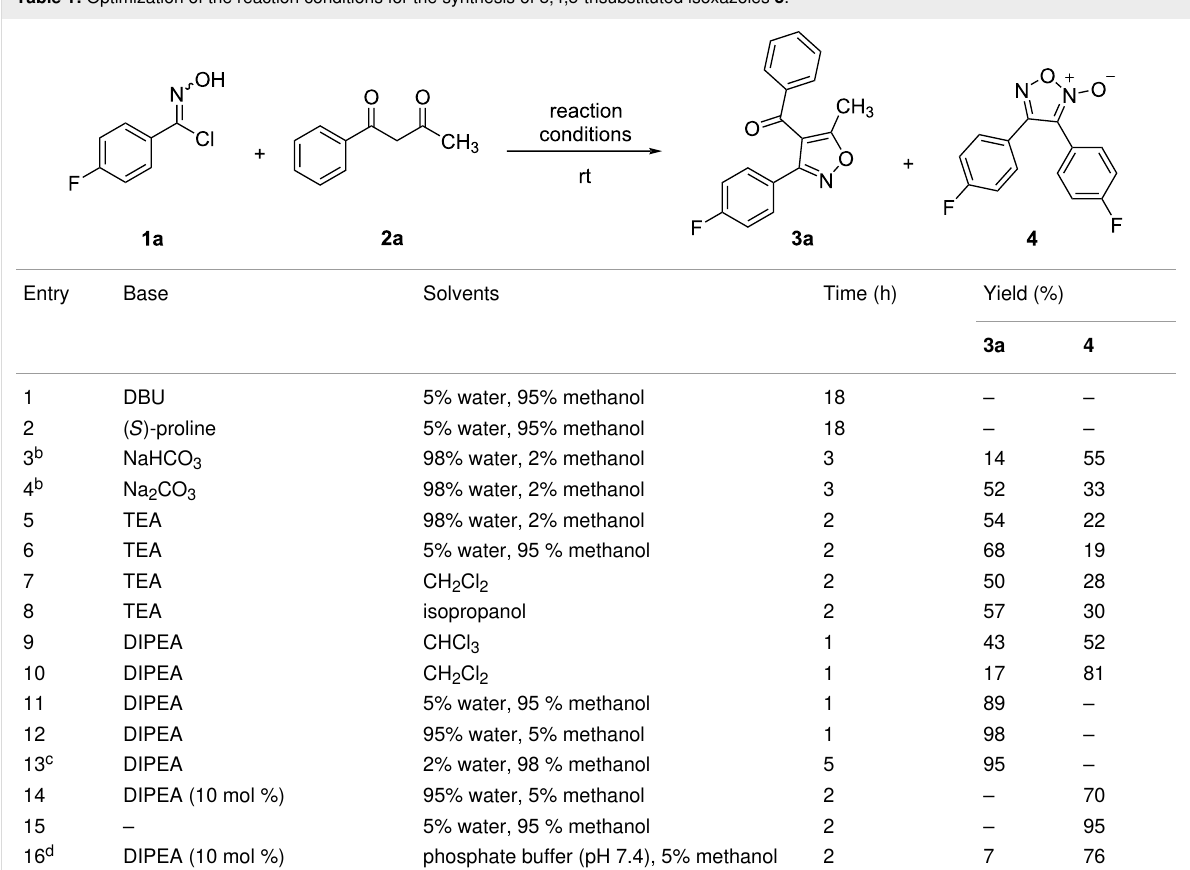
Table 1: Optimization of the reaction conditions for the synthesis of 3,4,5-trisubstituted isoxazoles 3 .